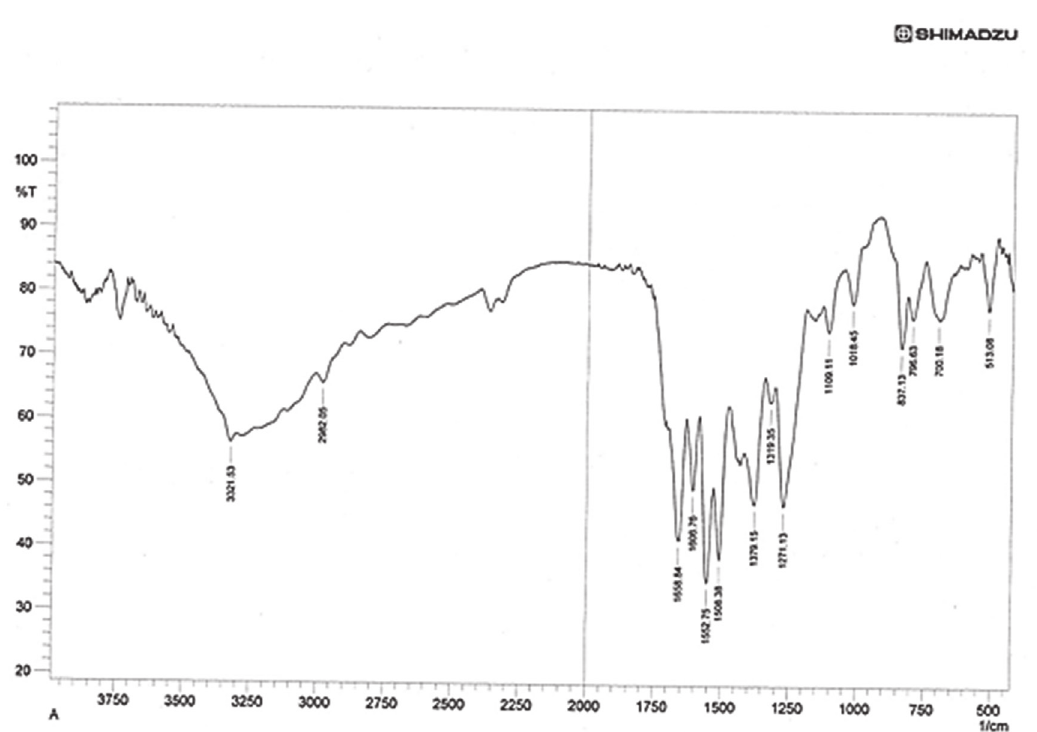
Figure 4: FTIR of